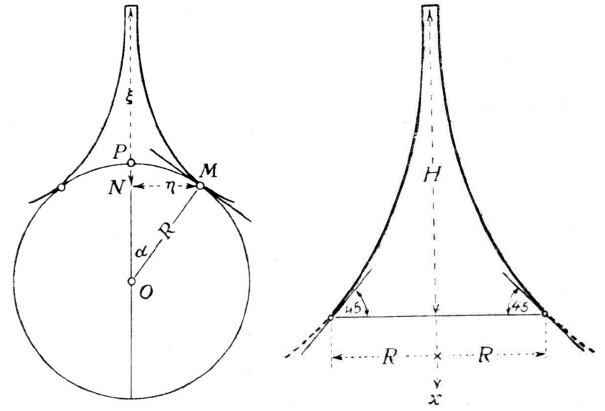
Figure 3. Milankovitch’s original drawings of the absolute highest and the highest rational